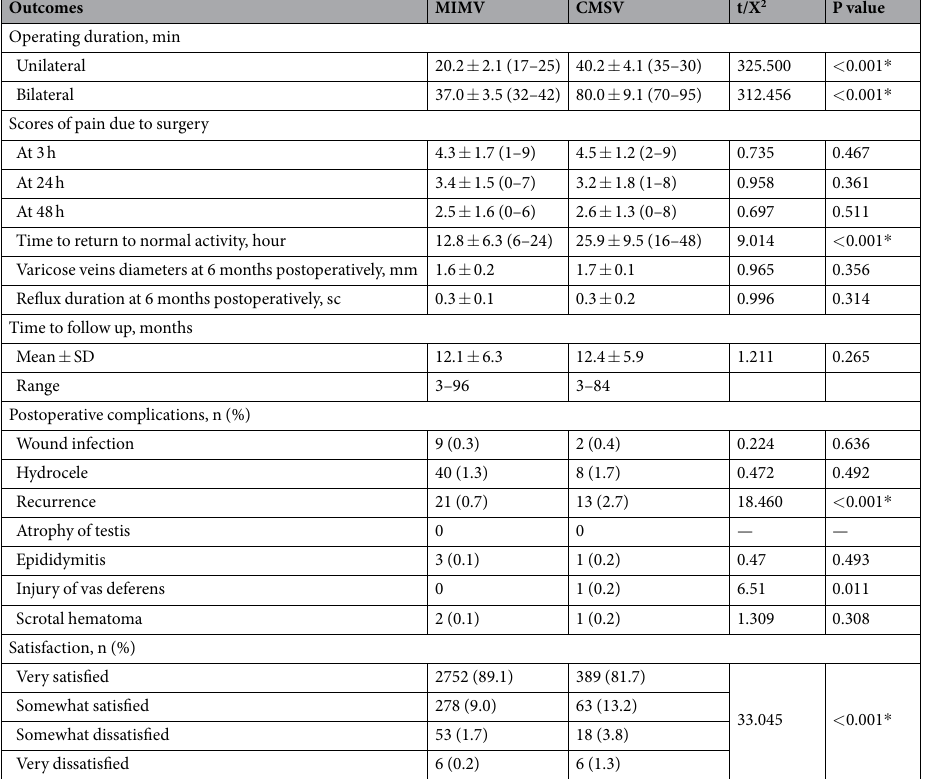
Table 2. Operative and postoperative outcomes of all the patients in two groups. * Means statistically significant difference.